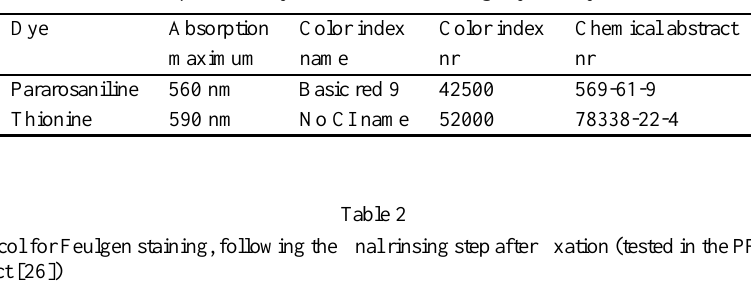
Properties of dyes used for DNA image cytometry